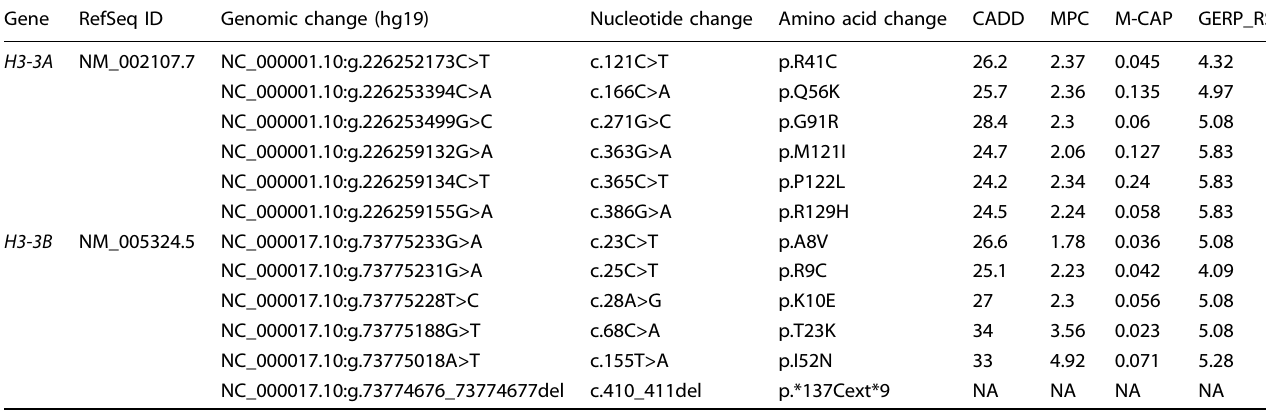
Table 1. Molecular characteristics of de novo H3-3A and H3-3B variants identi fi ed in individuals with neurodevelopmental disorders. Gene RefSeq